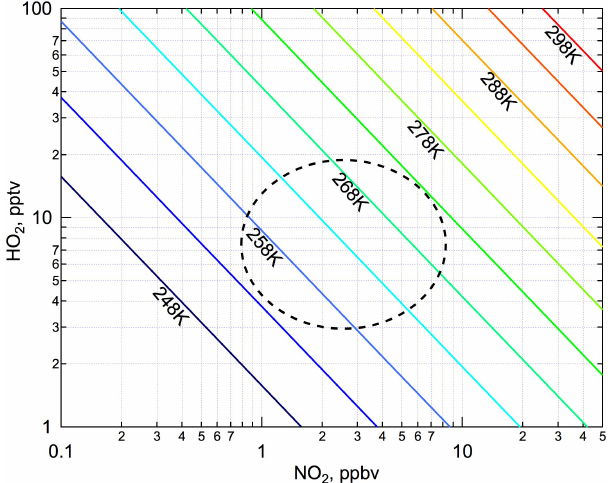
Figure 5. Temperature and mixing ratios of HO 2 and NO 2 required to sustain an equilibrium concentration of 1ppbv HO 2 NO 2 . The re- gion within the dashed circle superimposed on the figure highlights the conditions encountered during the 2013 UBWOS study. Data shown were calculated using the IUPAC database (Atkinson et al.,